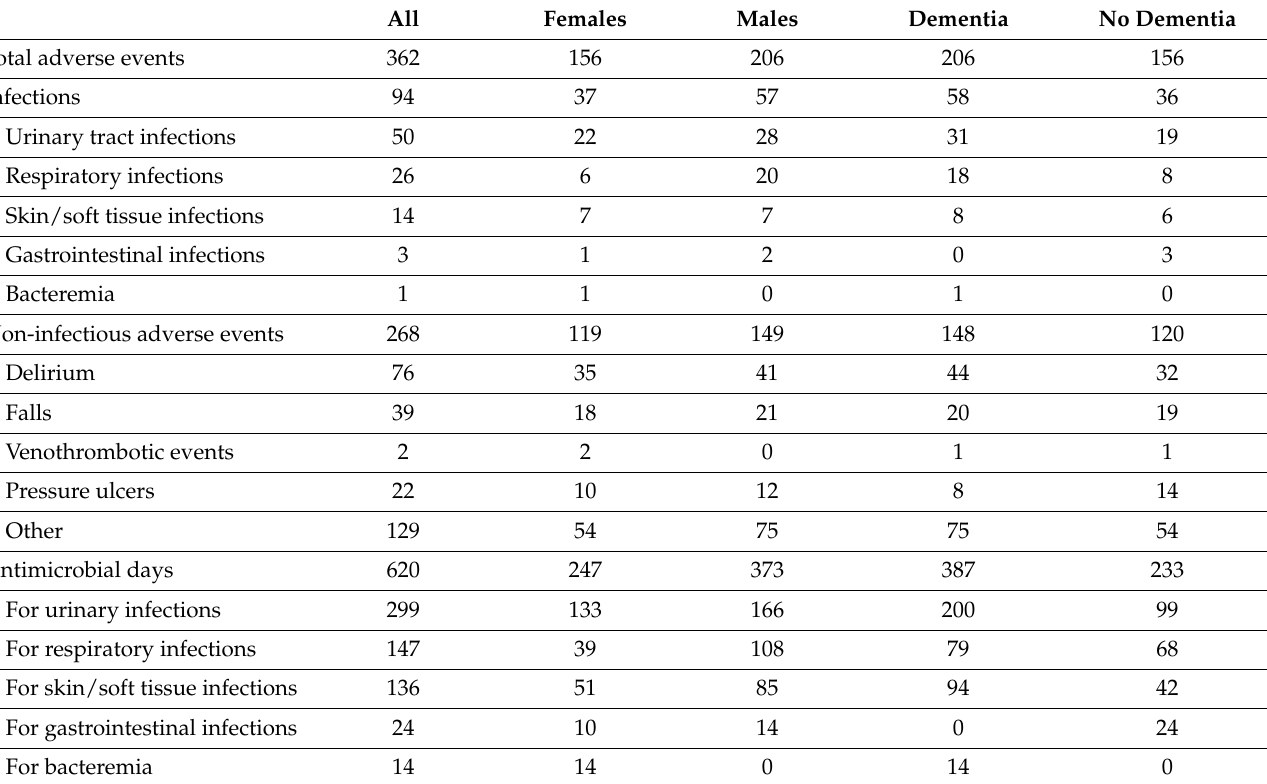
Table 3. Adverse events during ALC